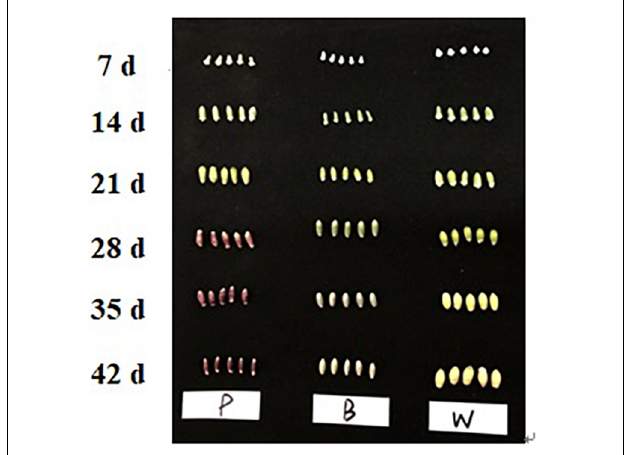
FIGURE 2 | Three wheat seed varieties at different developmental